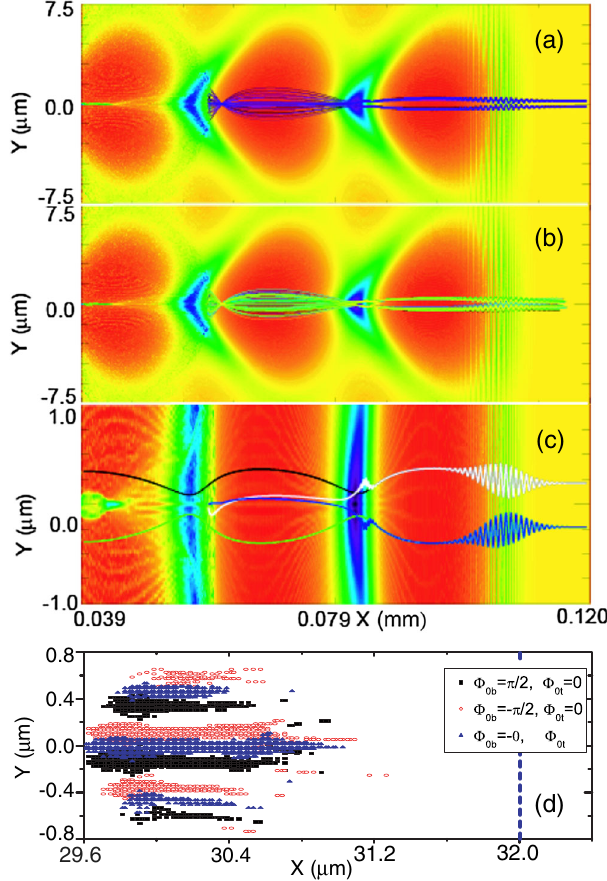
FIG. 2. (a) Trajectories of trapped preionized electrons. The x − X axis of the trajectories is X . The background shows e laserfront the plasma density after the laser pulse has propagated 0.12 mm. (b) Trajectories of the laser-ionized electrons. (c) Two typical electron trajectories without the colliding pulses (black and green curves) and with the colliding pulses (white and blue curves). The background shows the zoomed wake as shown in (a) and (b). (d) Initial positions of the preionized electrons changing with the initial phase of the transverse colliding pulses. The dashed blue line shows the propagation axis of the two transverse colliding